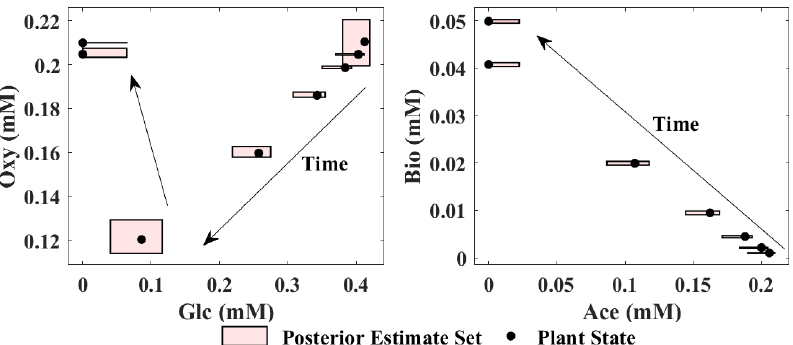
Figure 4. Posterior estimate sets projected onto the glucose–oxygen subspace and the acetate–biomass subspace at different